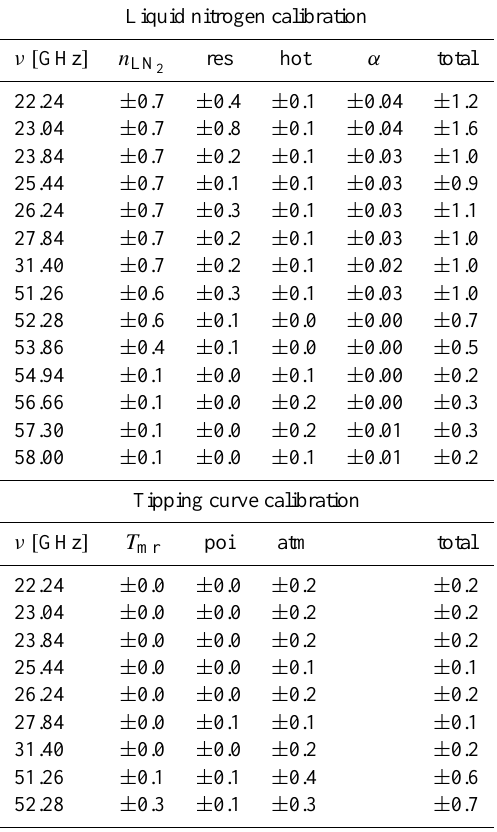
Table 5. Assessed total calibration uncertainties for RHUBC-II in Kelvin. For the LN 2 calibration, the total uncertainty results from uncertainties of the refractive index of the LN 2 surface ( n LN ), from 2 resonances between the receiver and the LN 2 target (res), from un- certainties in the in-situ hot load measurement (hot), and from the detector non-linearity ( α ). The uncertainties are assessed for the mean T b values measured at each channel on 16 August 2009. For the tipping curve calibration the total uncertainty results from the derivation of the mean radiative temperature ( T mr ), from the beam pointing (poi), and from atmospheric inhomogeneities (atm). Liquid nitrogen